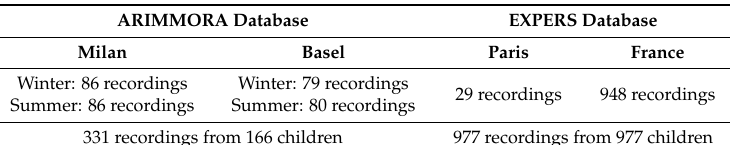
Table 1. ELF-MF exposure databases.